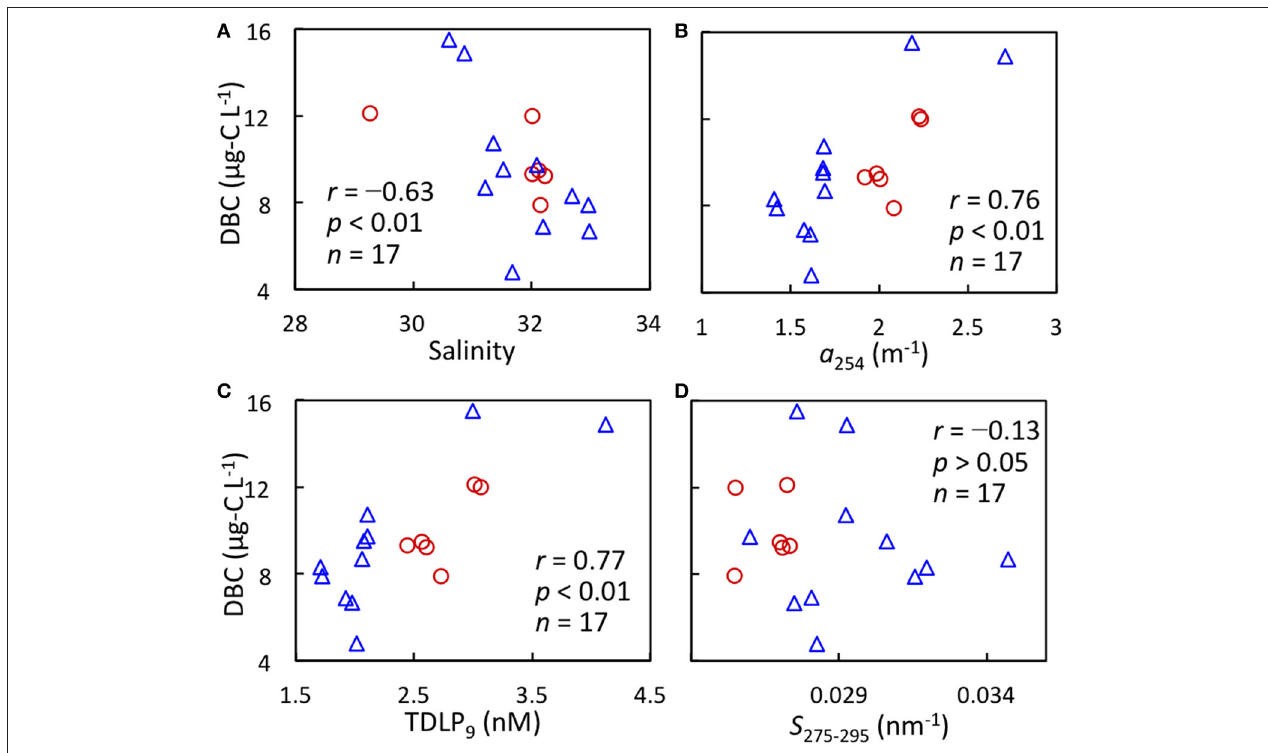
FIGURE 5 | Relationships between DBC concentration and salinity (A) , a 254 (B) , estimated TDLP 9 (C) , and S 275 − 295 (D) in surface waters of the Chukchi Sea (red circle) and Bering Sea (blue